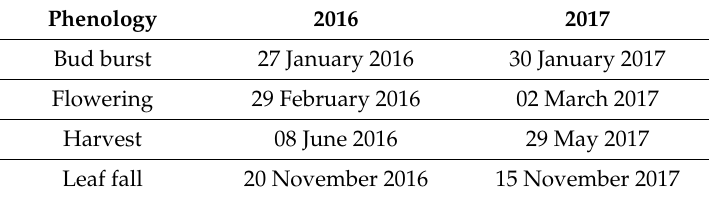
Table 1. Phenology of the crop for the di ff erent years of the